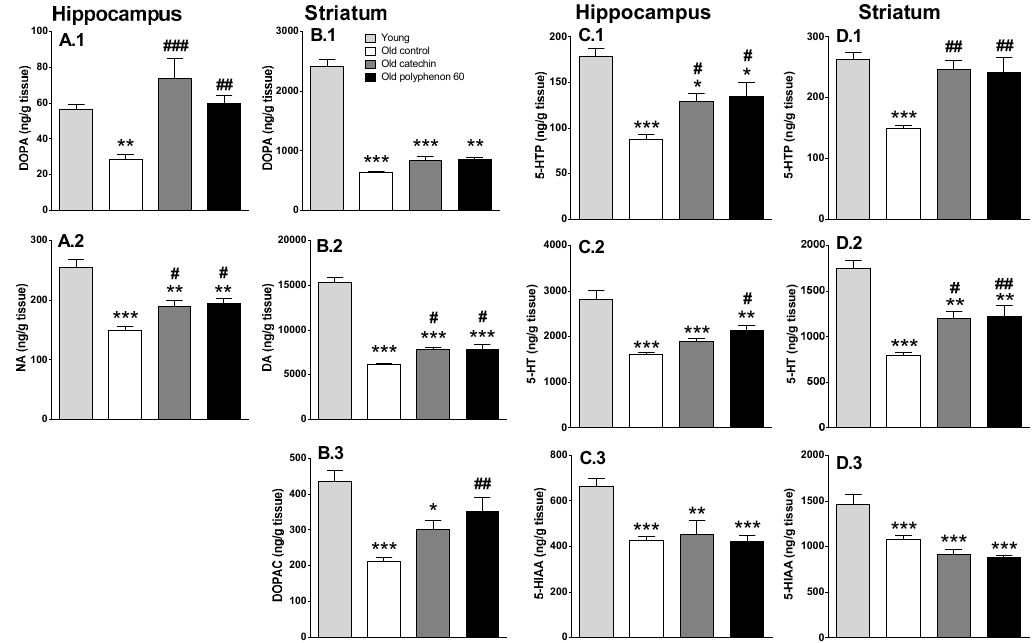
Figure 2. E ff ect of chronic polyphenon-60 and catechin treatments in catecholaminergic and serotonergic systems in hippocampus and striatum of old rats (18 months) and comparison with young rats (3 months). Catecholaminergic systems ( A and B graphs): bars represent (mean ± SEM in ng / g of wet tissue) DOPA accumulation (during 30 min after decarboxylase inhibition) and NA or DA tissue content in hippocampus and striatum, respectively. DOPAC metabolite levels in striatum are also represented. Serotonergic systems ( C and D graphs): bars represent (mean ± SEM in ng / g of wet tissue) 5-HTP accumulation (during the 30 min after decarboxylase inhibition), 5-HT tissue content, and 5-HIAA metabolite levels in hippocampus and striatum. Animals were treated with catechin ( n = 5; grey bars) or polyphenon-60 ( n = 6; black bars) (20 mg / kg, i.p., for 28 days; followed by 40 mg / kg, i.p., during an additional 7 days; both). Control animals received 1 mL / kg of corn oil for 40 days (i.p.; n = 6; white